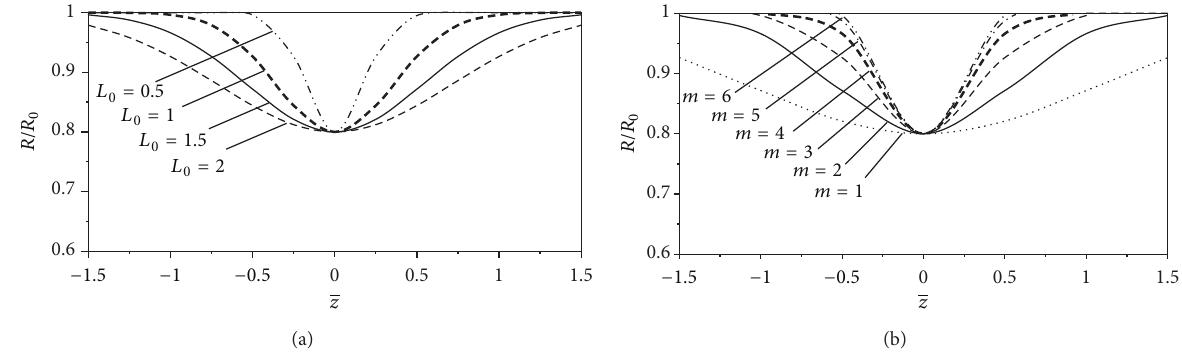
Figure 3: (a) Shapes of the arterial stenosis for different values of the stenosis length 𝐿 0 . (b) Shapes of the arterial stenosis for different values of the stenosis shape parameter 𝑚